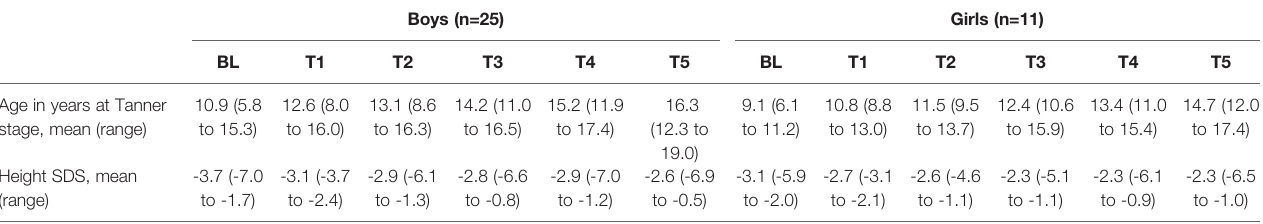
TABLE 2 | Height SDS at different Tanner stages of the subgroup of children receiving rhIGF-1 who reached the end of puberty during the time period of this analysis a